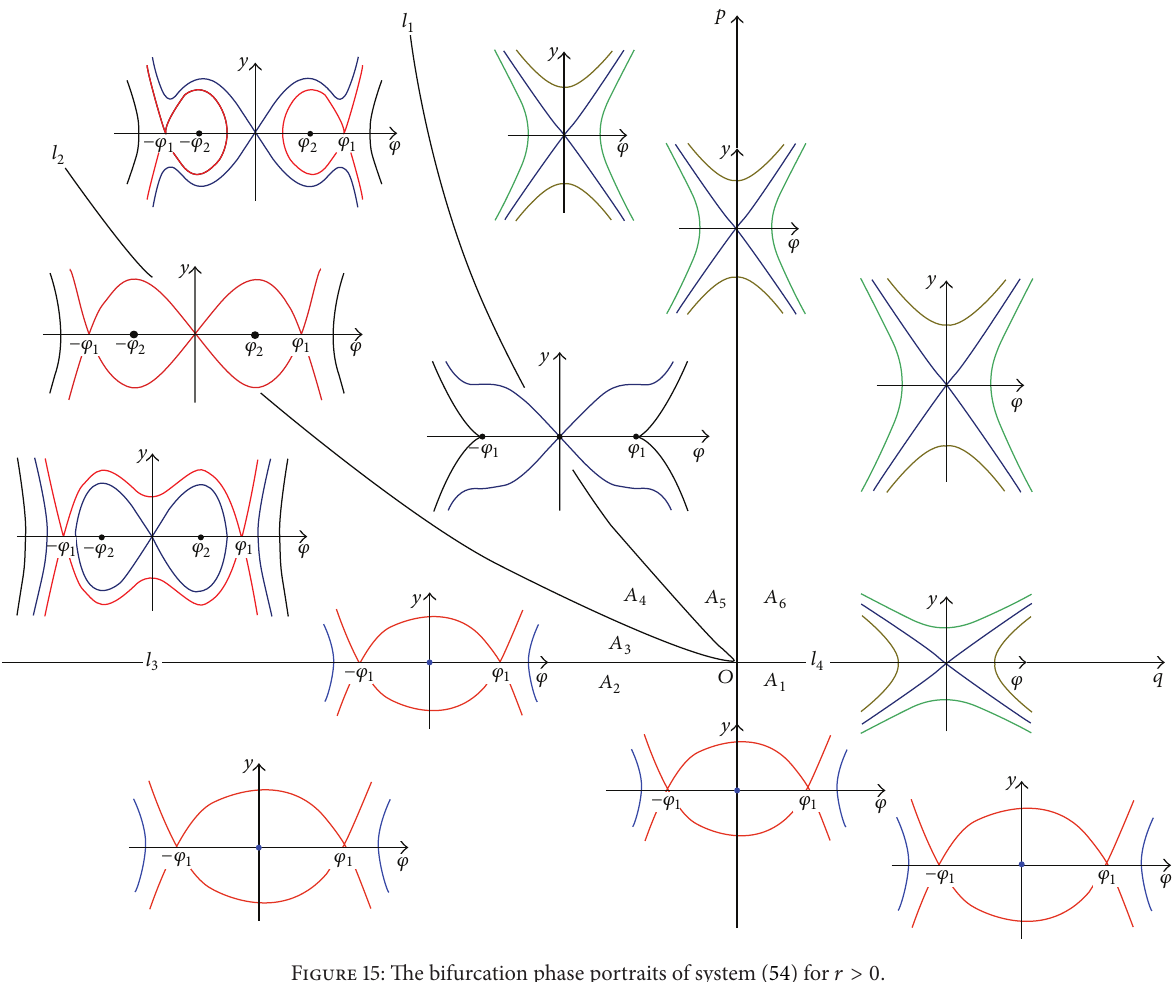
Figure 15: The bifurcation phase portraits of system (54) for 𝑟 > 0